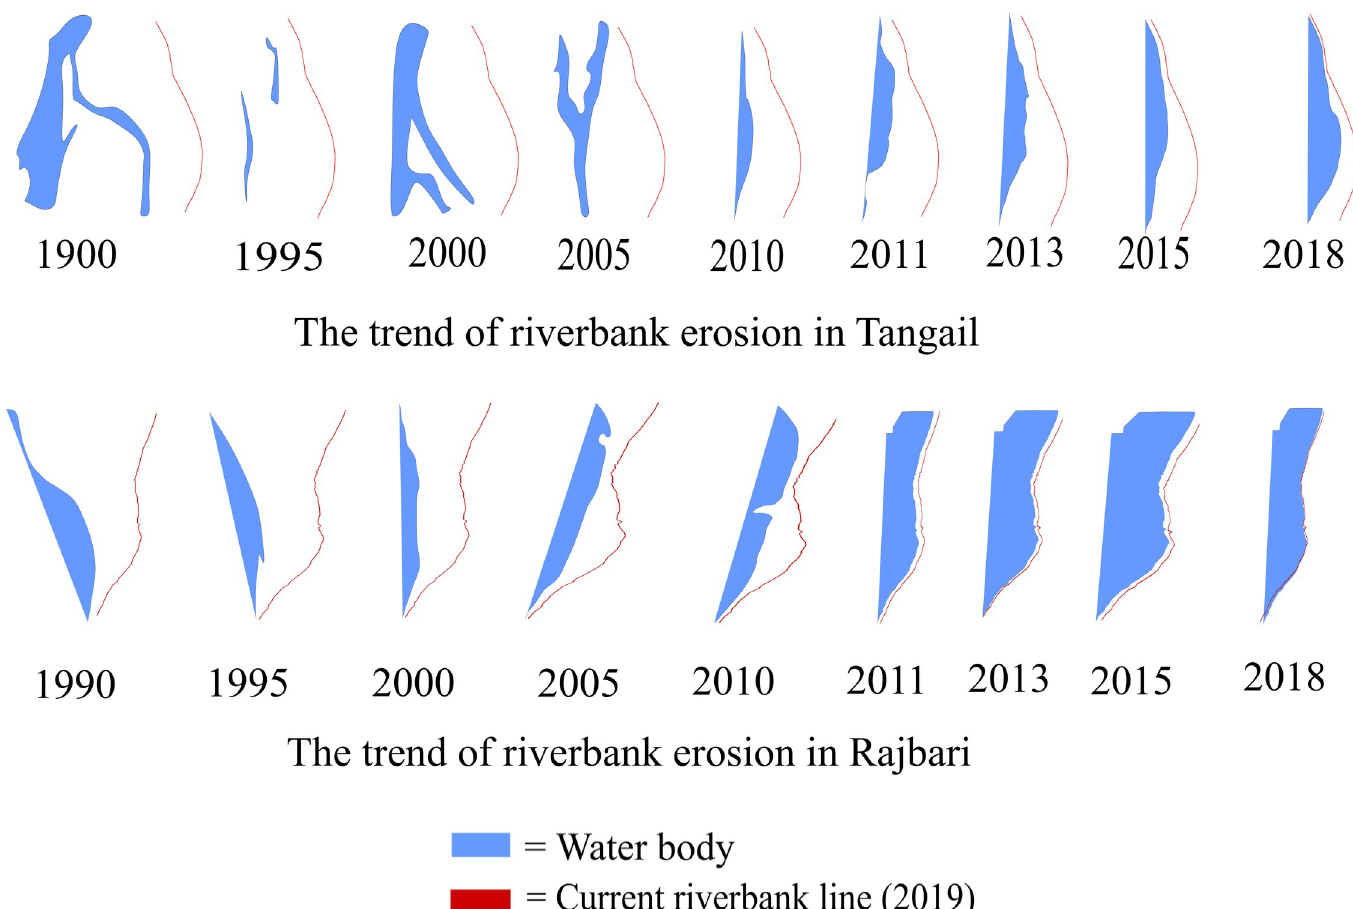
Fig 1. The trend of riverbank erosion of the study